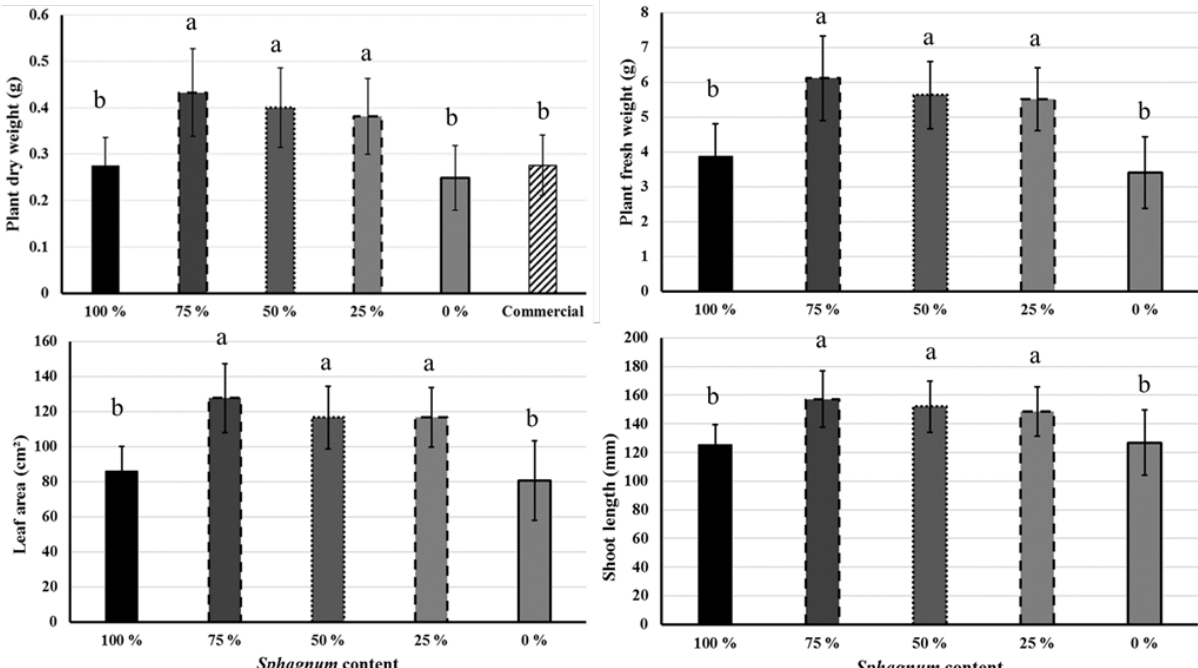
Figure 2. Assessed indicators for the growth of sweet basil in various mixtures of Sphagnum and peat. Dry weights of plants grown in commercial growing media were assessed for reference (top left). Letters (a, b) denote significant differences between groups (p < 0.05) for measurements (n = 12) and analyses (n =